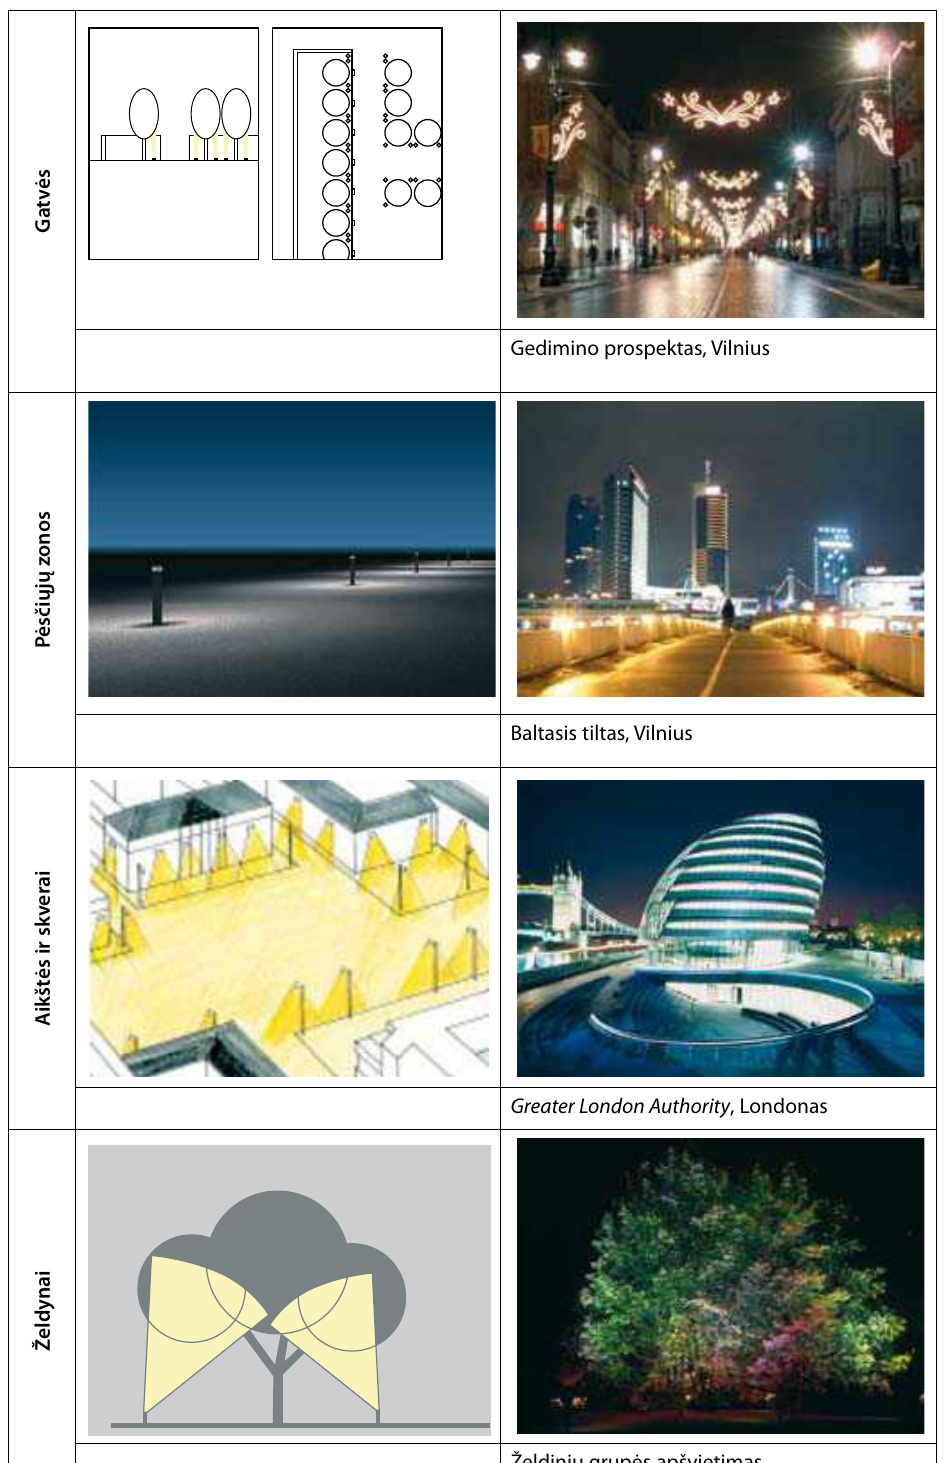
Table 2. Types of lighting by